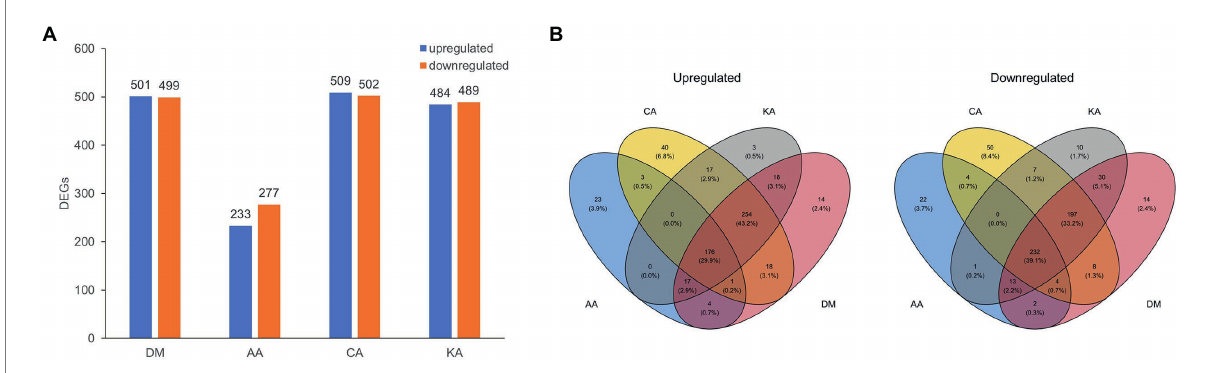
FIGURE 4 DEGs detected in comparison between diterpenoid-untreated and diterpenoid-treated samples. Streptococcus mutans was treated with DM, AA, CA, and KA. (A) Up- and downregulated number of DEGs, (B) Venn diagram showing unique and shared DEGs. DEGs with >1.0-fold change and p < 0.05 were clustered across all